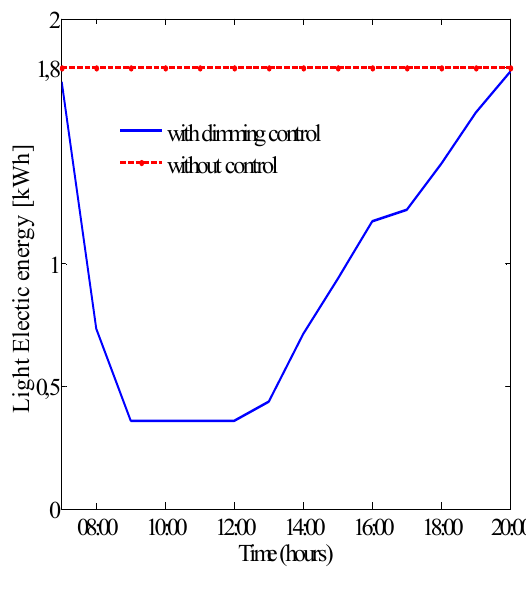
Figure 3. Electricity consumption of the lighting with dimming control